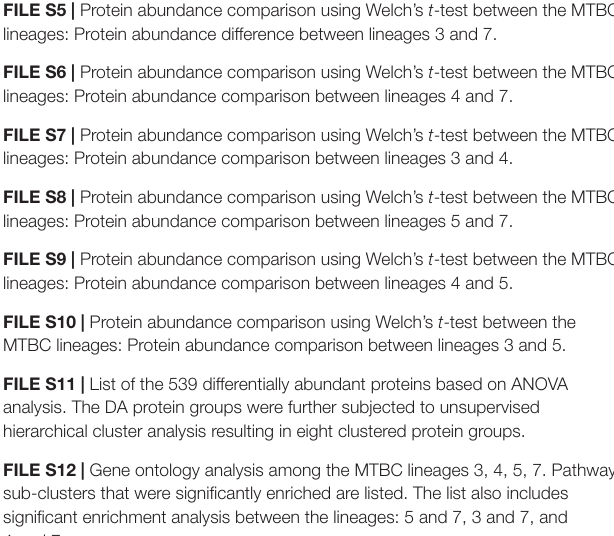
hierarchical cluster analysis resulting in eight clustered protein